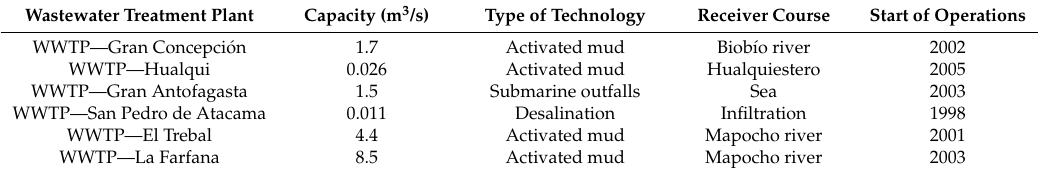
Table 8. Construction of wastewater treatment facilities in study areas.